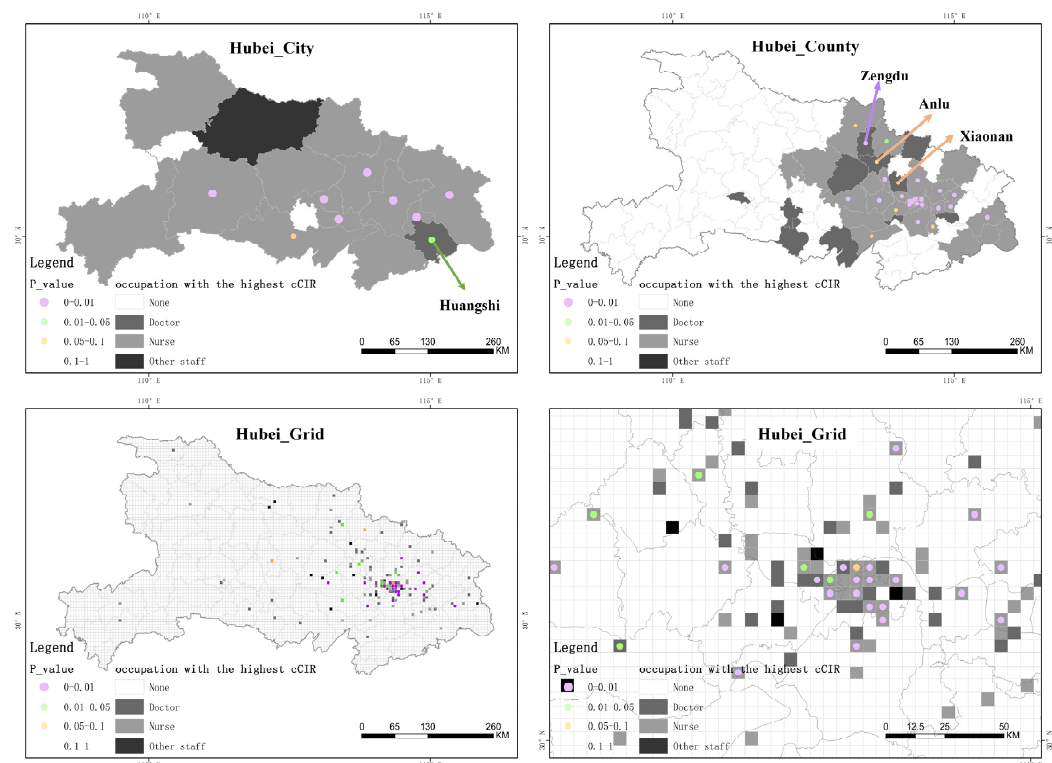
Figure 6. The occupation type with the highest infection rate and chi-square p -value classification.